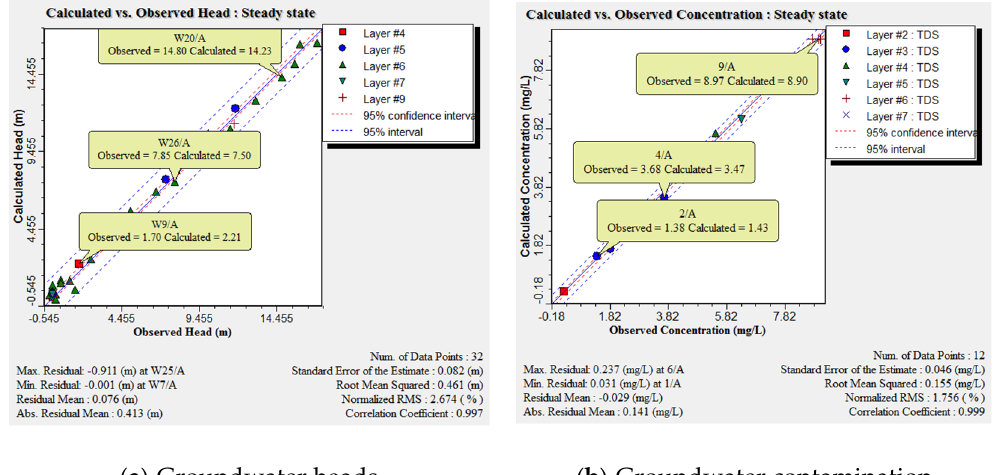
Figure 6. Observed groundwater results versus calculated ones.